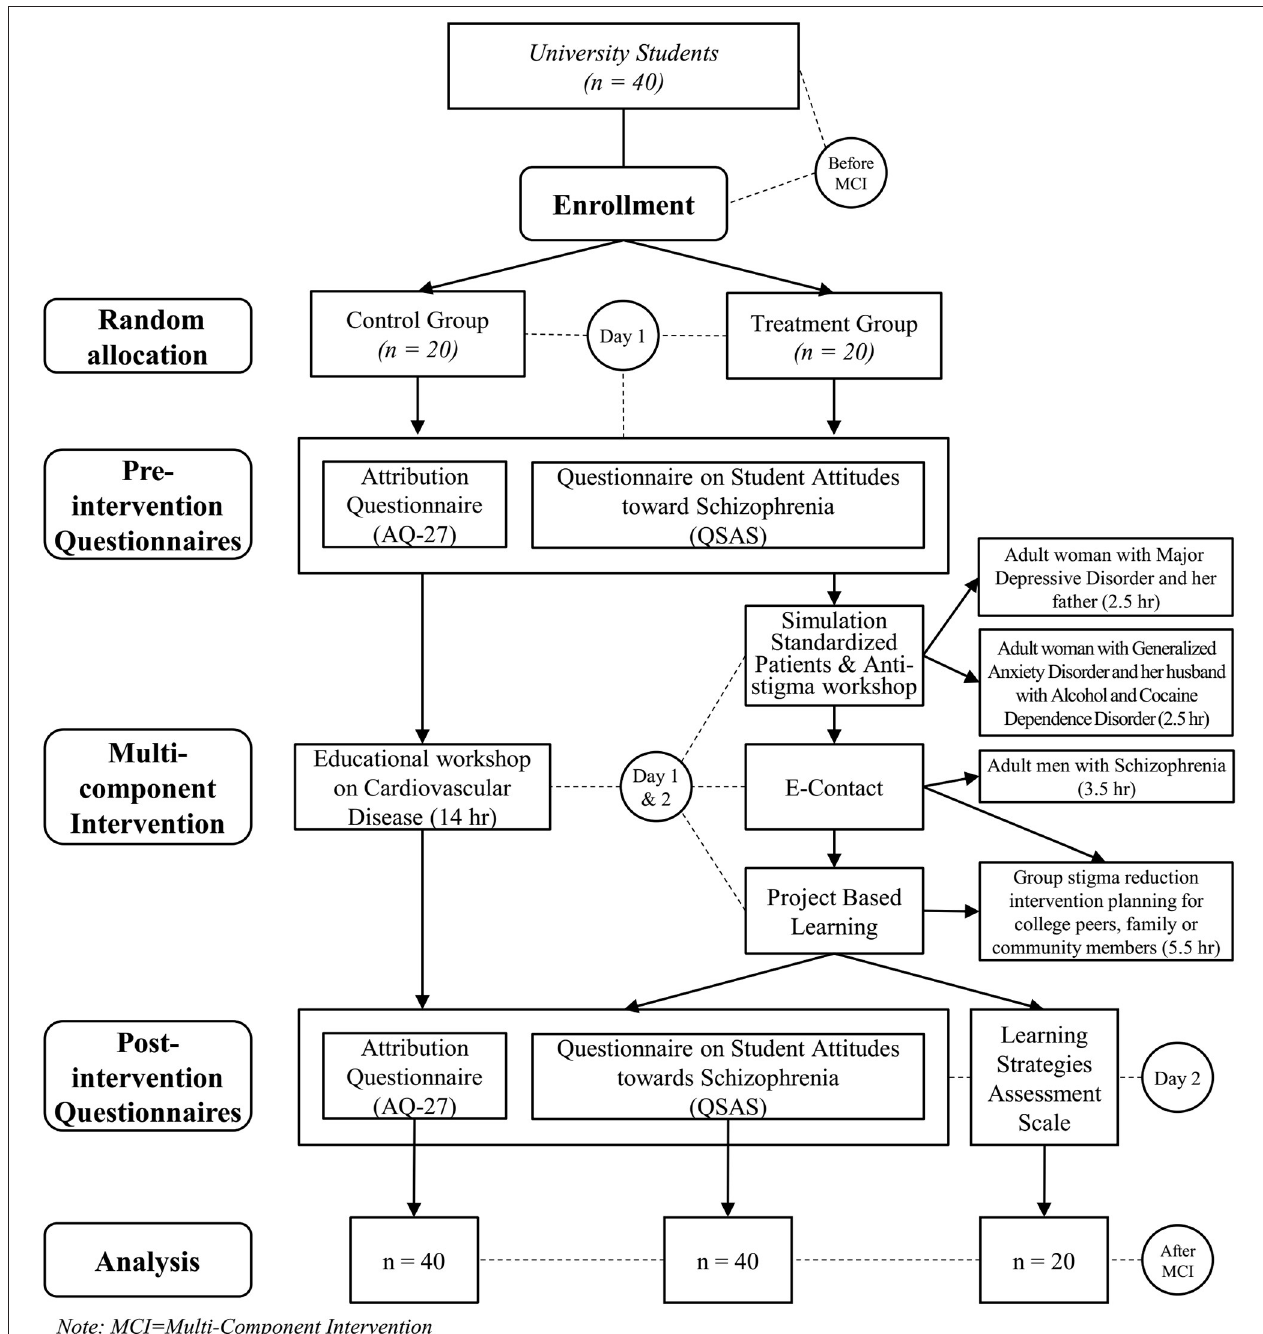
FIGURE 1 | Participant assignment procedure to the multicomponent intervention